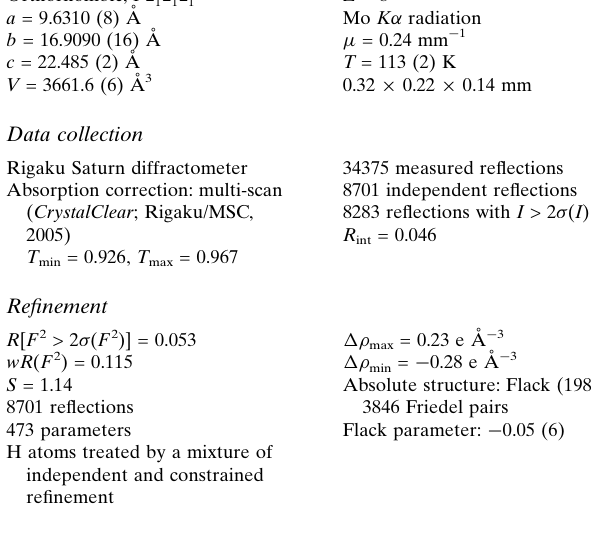
Rigaku Saturn diffractometer Absorption correction: multi-scan ( CrystalClear ; Rigaku/MSC, 2005)